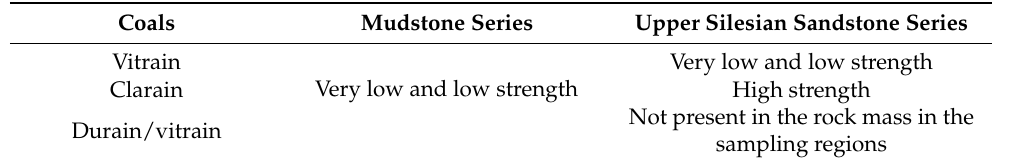
Table 6. Coal uniaxial compressive strength